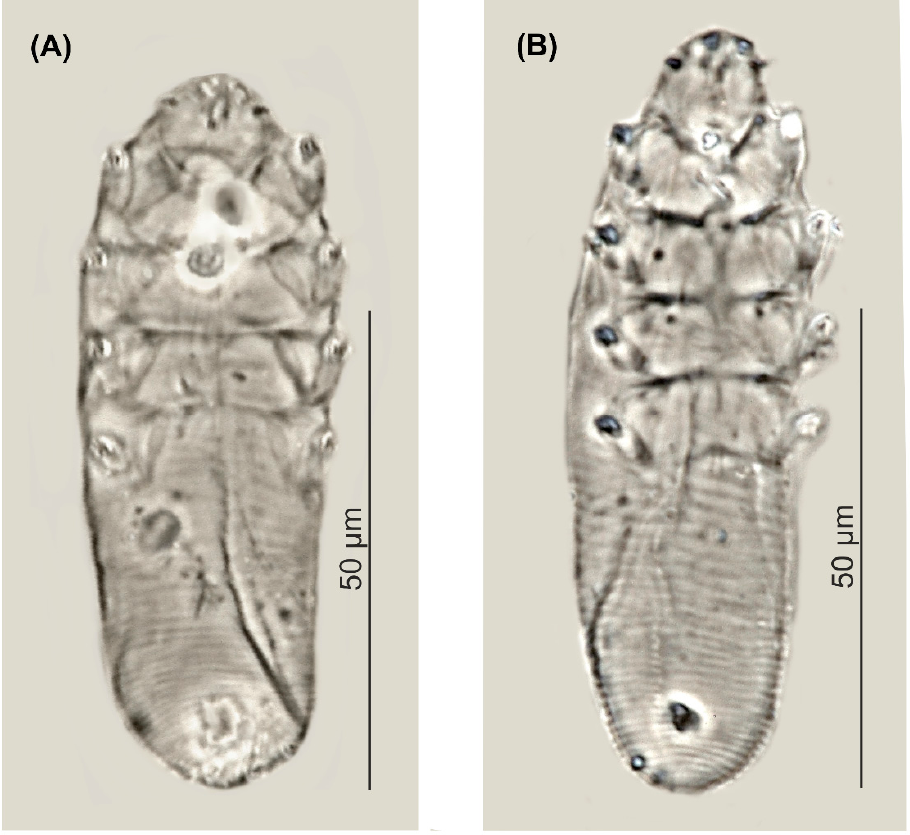
Figure 2. Demodex pusillus sp. nov.: male ( A ) and female, holotype ( B